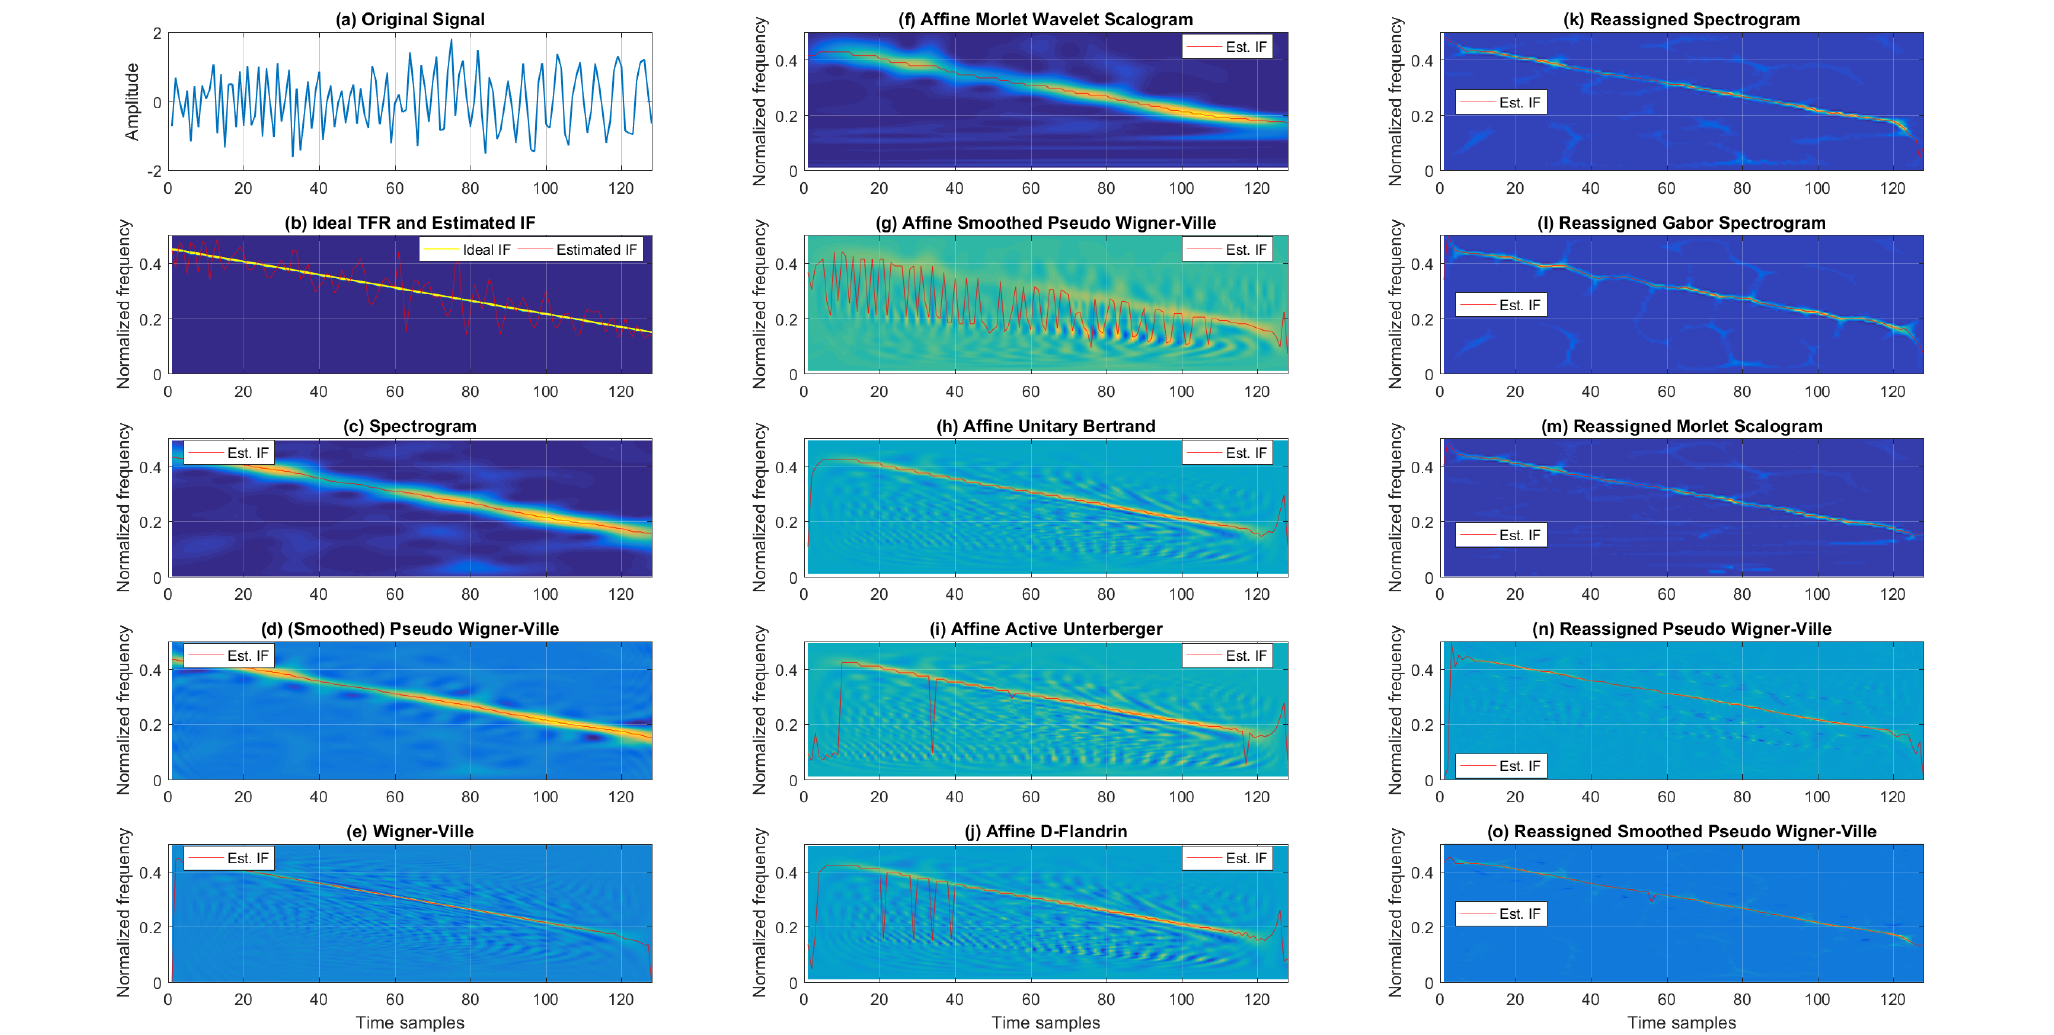
Figure 3. TFRs of a noisy mono-component linear FM signal with estimated IFs for the SNR of 5